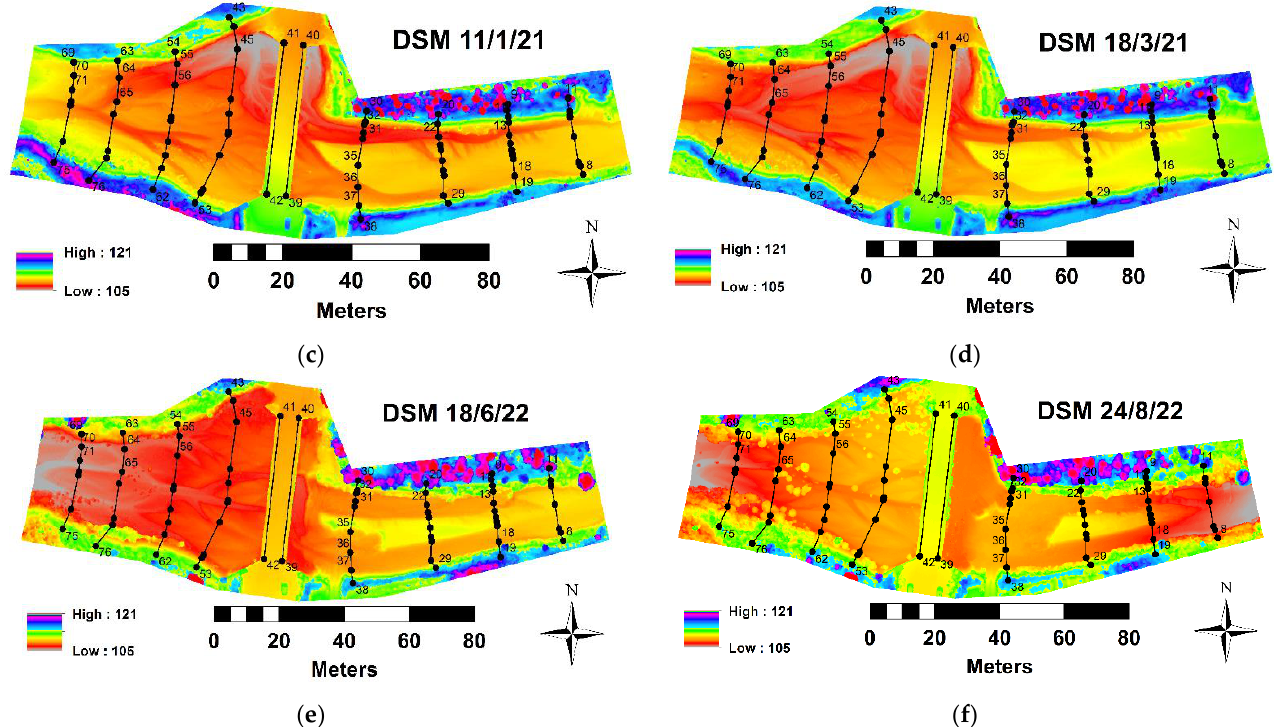
Figure 7. The produced DSMs for each UAV flight: ( a ) 24 September 2020, ( b ) 5 January 2021, ( c ) 11 January 2021, ( d ) 18 March 2021, ( e ) 18 June 2022 and ( f ) 24 August 2022. In addition, the field cross-section survey based on the GPS/GNSS is also depicted in each DSM.